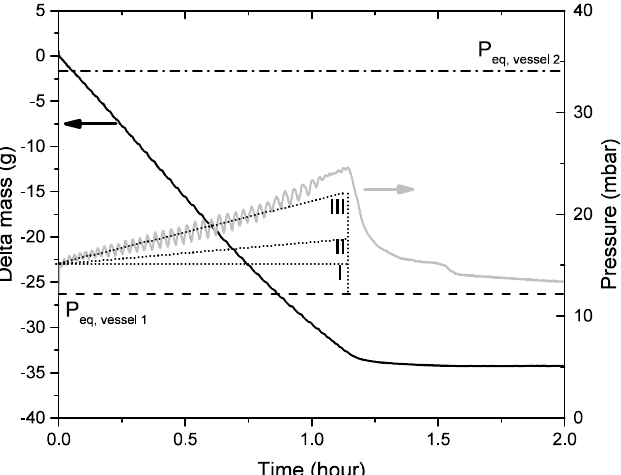
Figure 6. Left axis: Mass change of vessel 2 during evaporation (solid line). Right axis: Pressure in setup during mass transport from vessel 2 into 1 (grey line). The equilibrium pressures of vessel 1 and 2 are indicated by the dashed (–) the and dot-dashed ( · –) lines respectively. The three dotted (...) lines represents the thinking model (see Figure 7) explaining the pressure increase during the evaporation/condensation: case I ( no non-condensable gases (NCG) are present in the system), case